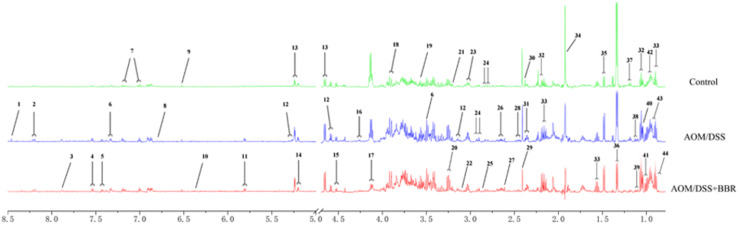
Typical 1H-NMR spectrum of fecal sample in different groups. Typical 600 MHz 1H NMR spectra of feces samples in the different groups. 1, formate; 2, hypoxanthine; 3, xanthine; 4, tryptophan; 5, phenylalanine; 6, 3-hydroxyphenylacetate; 7, tyrosine; 8, homovanillate; 9, fumarate; 10, urocanate; 11, uracil; 12, galactose; 13, glucose; 14, D-xylose; 15, arabinose; 16, threonine; 17, lactose; 18, aspartate; 19, glycine; 20, taurine; 21, methano; 22, choline; 23, lysine; 24, asparagine; 25, trimethylamine; 26, methionine; 27, methylamine; 28, glutamine; 29, succinate; 30, proline; 31, glutamate; 32, propionate; 33, butyrate; 34, acetate; 35, alanine; 36, lactate; 37, ethanol; 38, 3-methyl-2-oxoisovalerate; 39, 2-oxoisovalerate; 40, isobutyrate; 41, valine; 42, leucine; 43, isoleucine; 44, valerate.